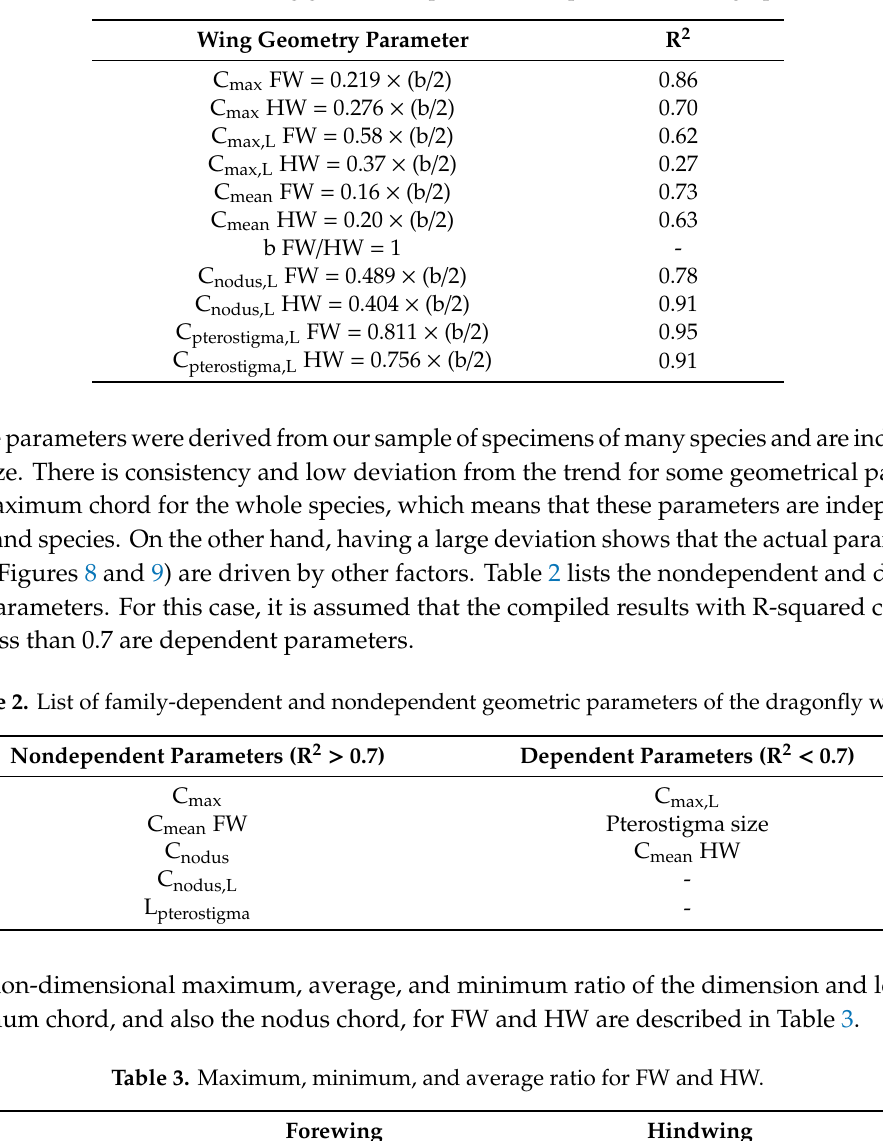
Table 1. Essential wing geometrical parameters exported from the graphs.